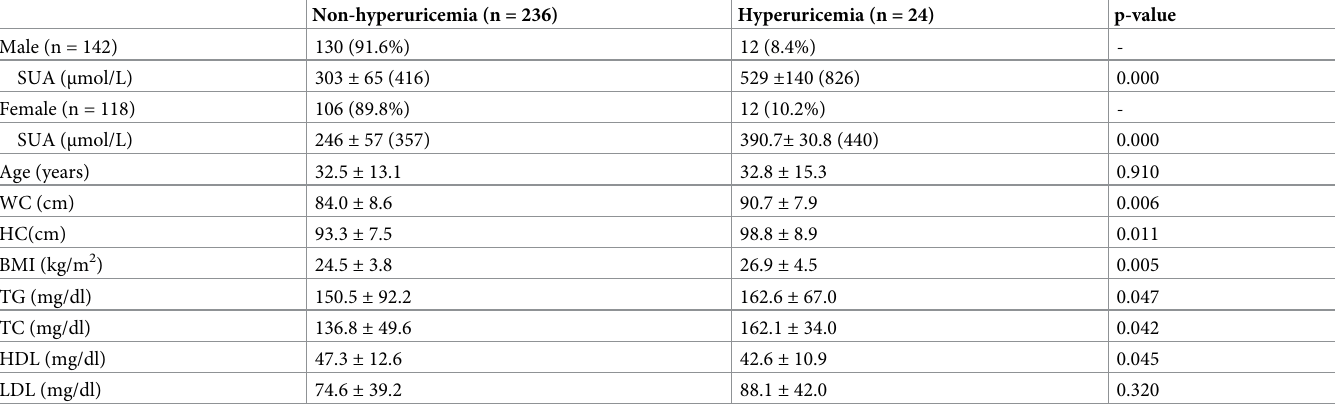
Table 2. Comparison of baseline characteristics between non-hyperuricemic and hyperuricemic subjects.